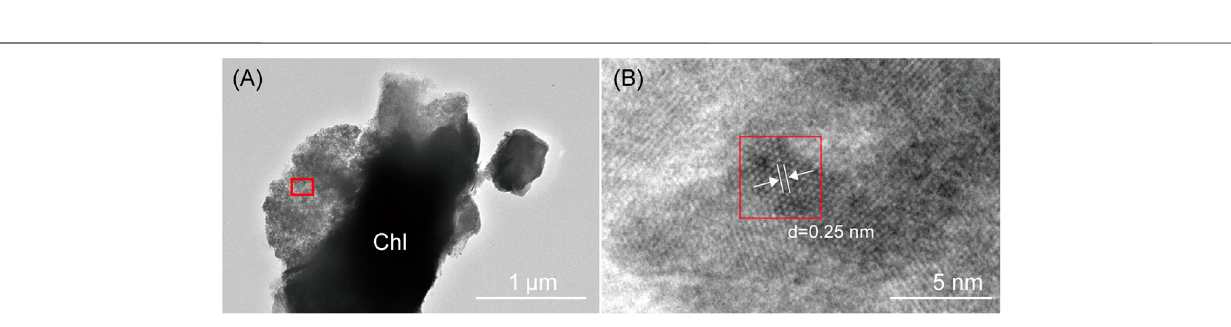
FIGURE 6 | TEM micrographs of the rusty parts from 0718. (A) Fe-bearing materials associated with chlorite. (B) High-resolution TEM image of the Fe-bearing materials and the Fourier transform of a single crystal framed in the red rectangle.